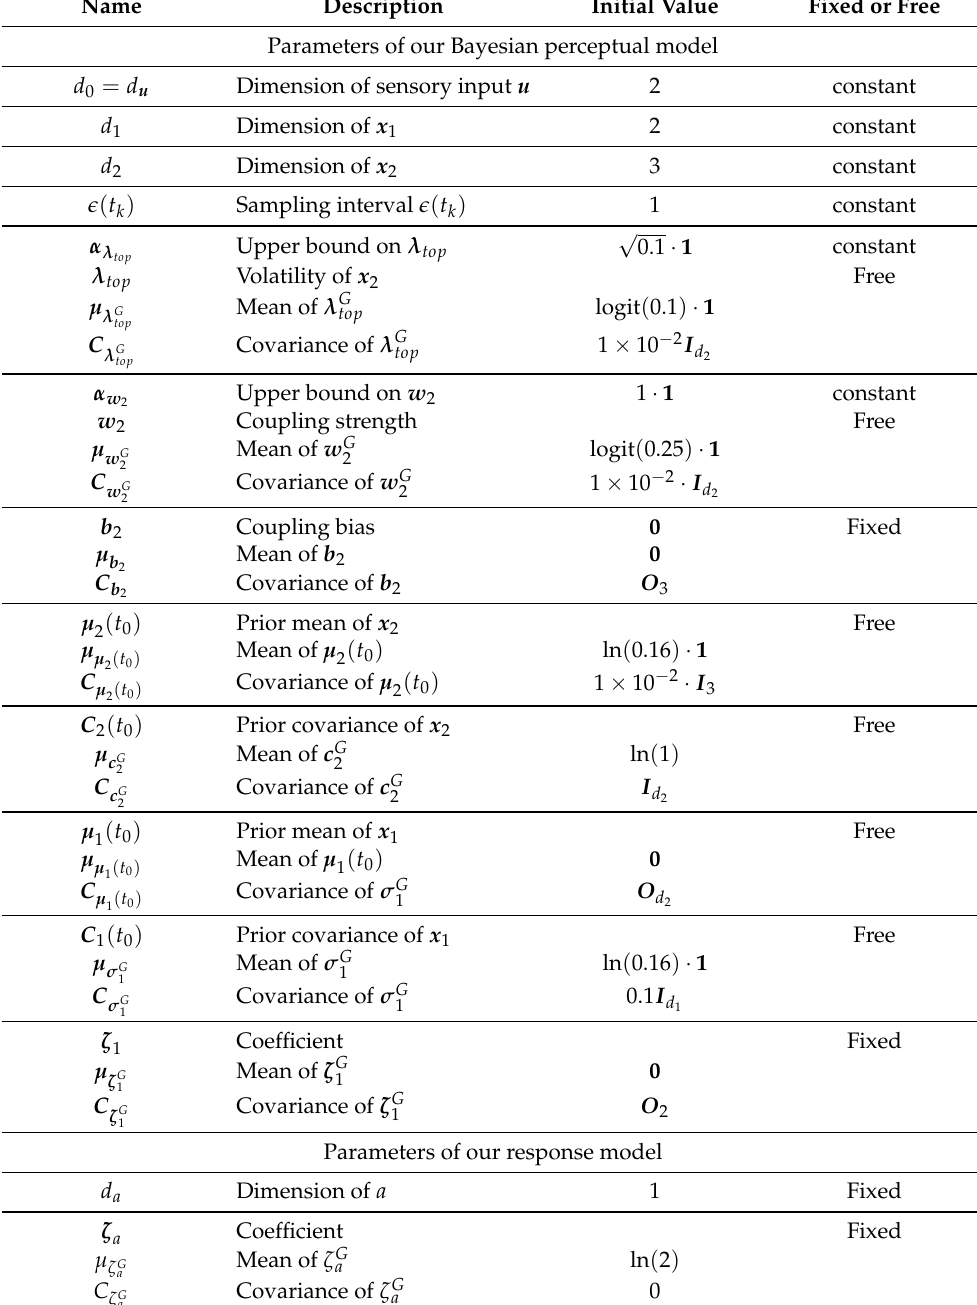
Table 2. Parameters of our hierarchical Bayesian model. Parameters labeled by ‘Free’ are optimized by the inversion of the model. Fixed parameters are constant and not optimized. The notation 1 is a constant column vector with all components being 1. The notation 0 is a zero vector. The matrix O d is a d by d constant matrix in which all elements are 0. The notation logit ( ) . Given all initial priors, we search for the optimal priors on all optimized function logit ( x ) = ln ( x x 1 − parameters µ according to the free energy principle (Equations (A19) and ξ